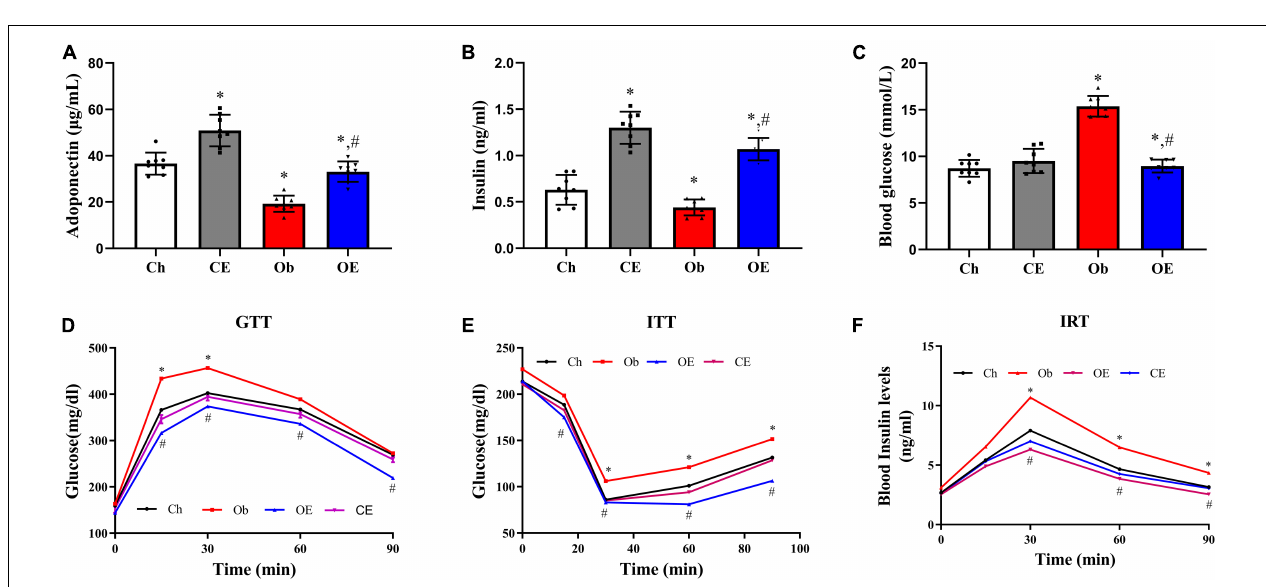
FIGURE 5 | Detection of oxidative stress-related genes in lung tissue. The levels of GSH (A) , MDA (B) , MPO (C) , and SOD (D) in lung tissue were detected. # P < 0.05 compared with the Ch group. ∗ P < 0.05 compared with the Ob group. MDA, malondialdehyde; MPO, myeloperoxidase; GSH, glutathione; SOD, superoxide